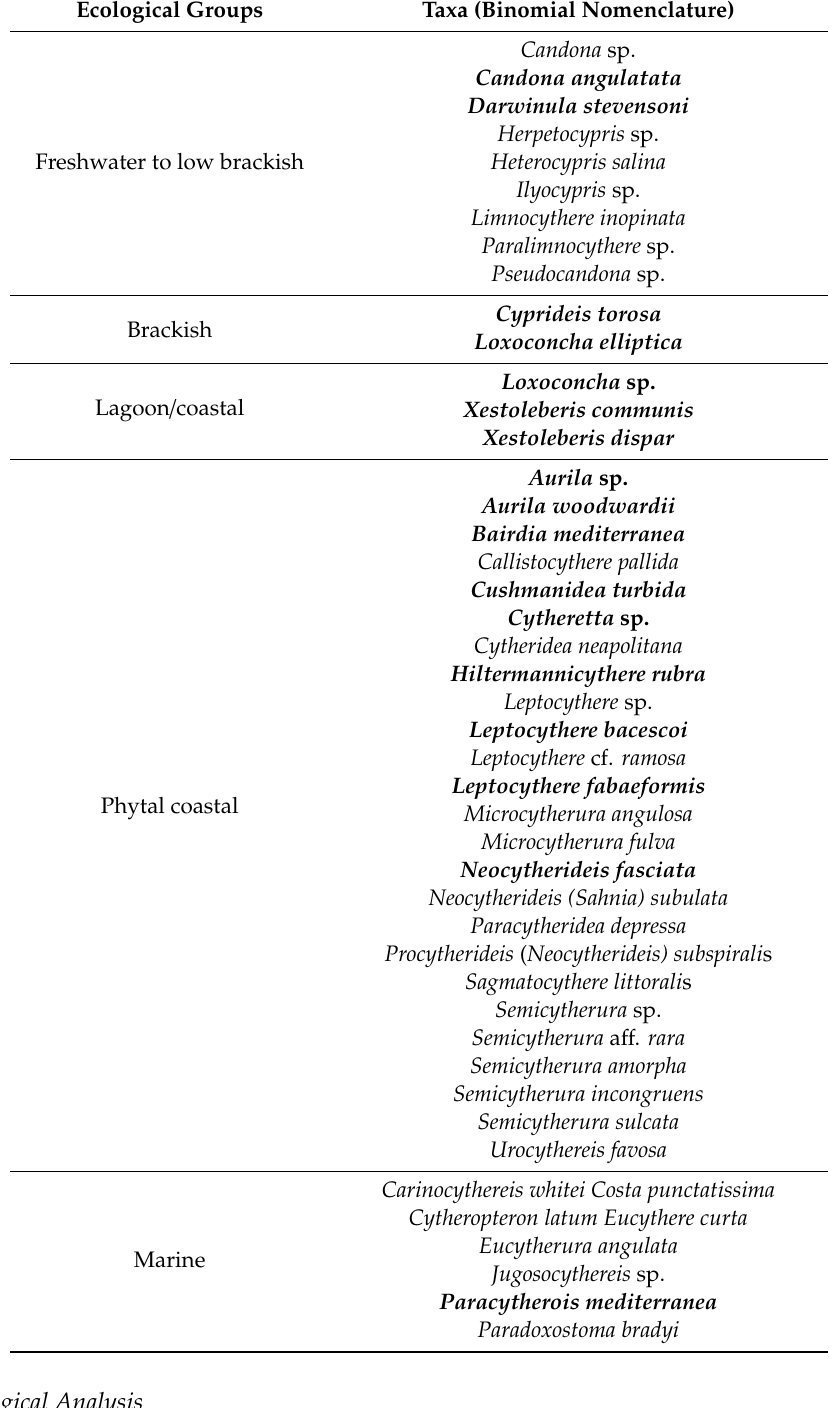
Table 1. Ecological groups with the related taxa (in bold the common taxa > 5